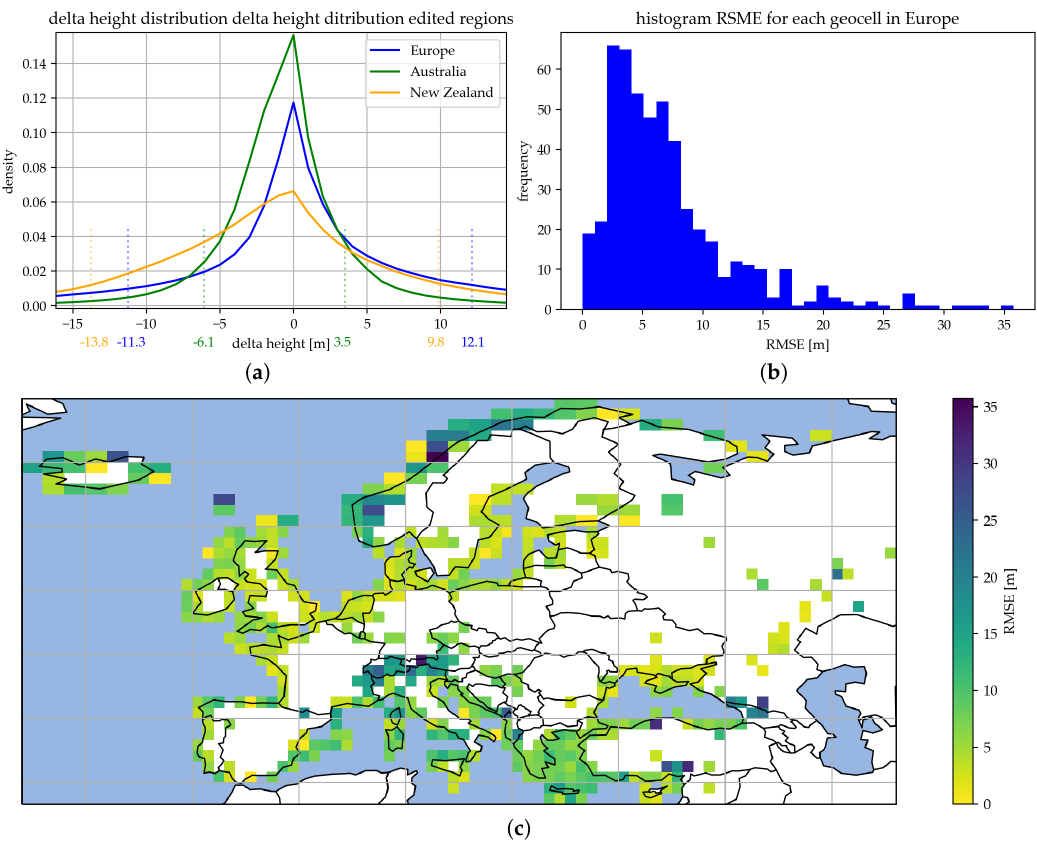
Figure 14. ( a ) Delta height density for all the edited regions vertical dotted lines show the 5th and 95th percentiles. ( b ) Histogram delta height RMSE for all edited regions in Europe grouped by geocell. ( c ) Distribution delta height RMSE for all edited regions in